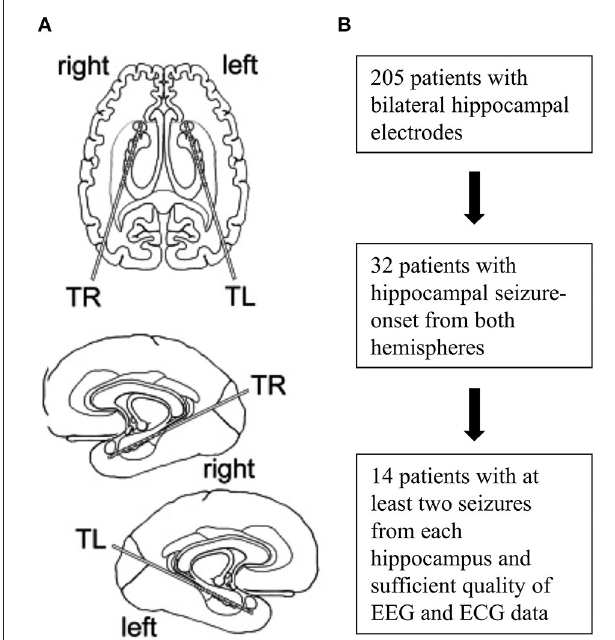
FIGURE 1 | Implantation scheme and flowchart of patient selection. Placement of intracranial depth electrodes for most patients (A) . Selection and inclusion of patients (B)